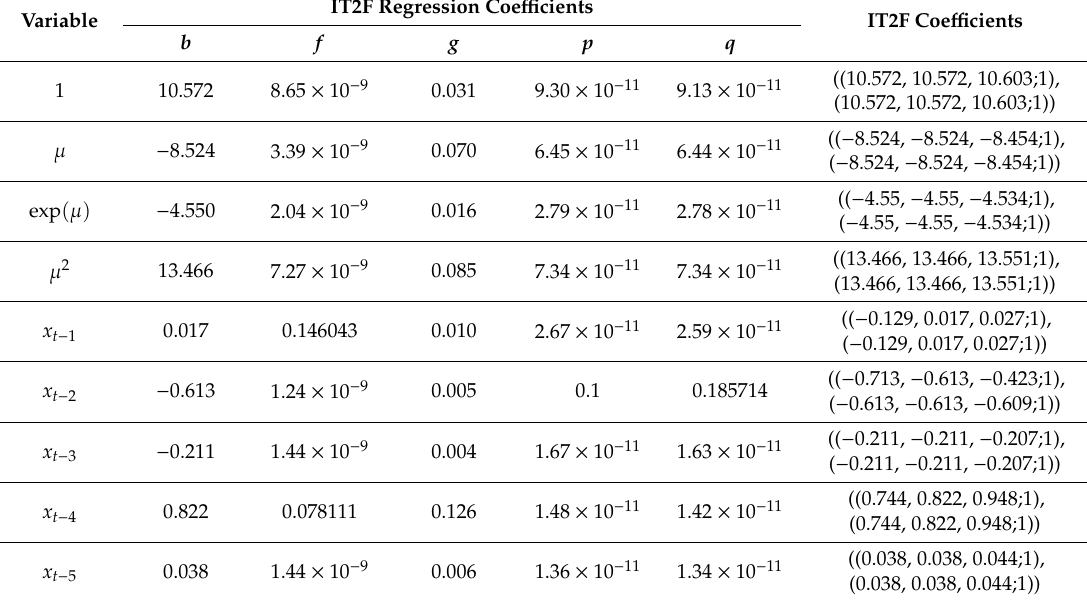
Table 4. Cluster 1 results for the 1st alternative and 1st criteria.